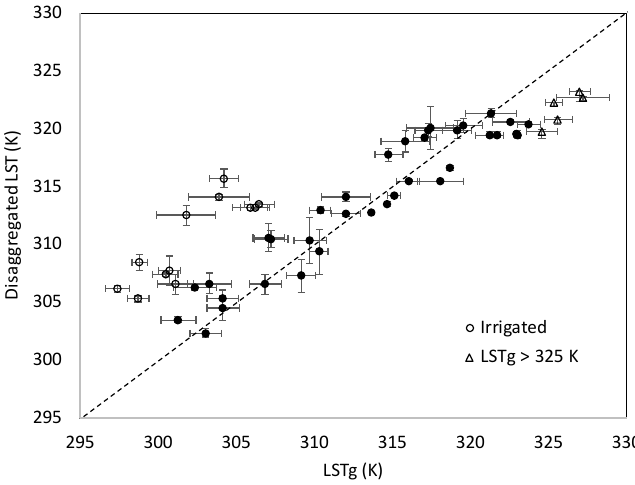
Figure 5. Linear regression between disaggregated LST 10m and ground-measured values (LST g ). Crop fields under recently irrigated conditions are labeled with a non-filled circle. Outlier high LST values are labeled with triangles. Dashed line represents the 1:1 agreement.